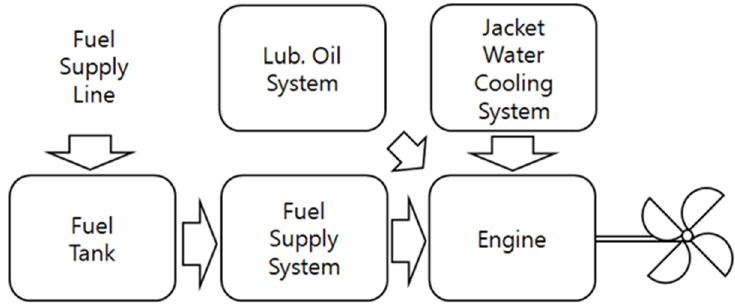
Figure 4. Mechanical propulsion system (diesel engine) schematic diagram.